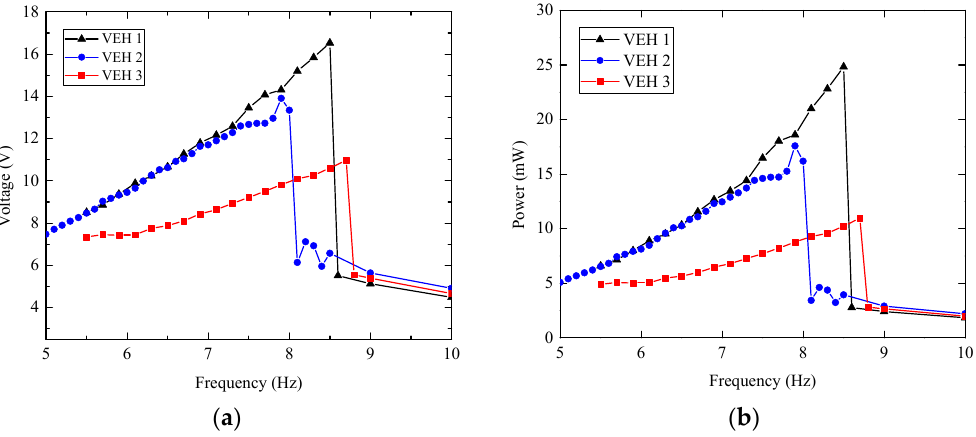
Figure 11. Output performances of VEHs under base excitation of 0.3 g : ( a ) output RMS voltage; and ( b ) output power.